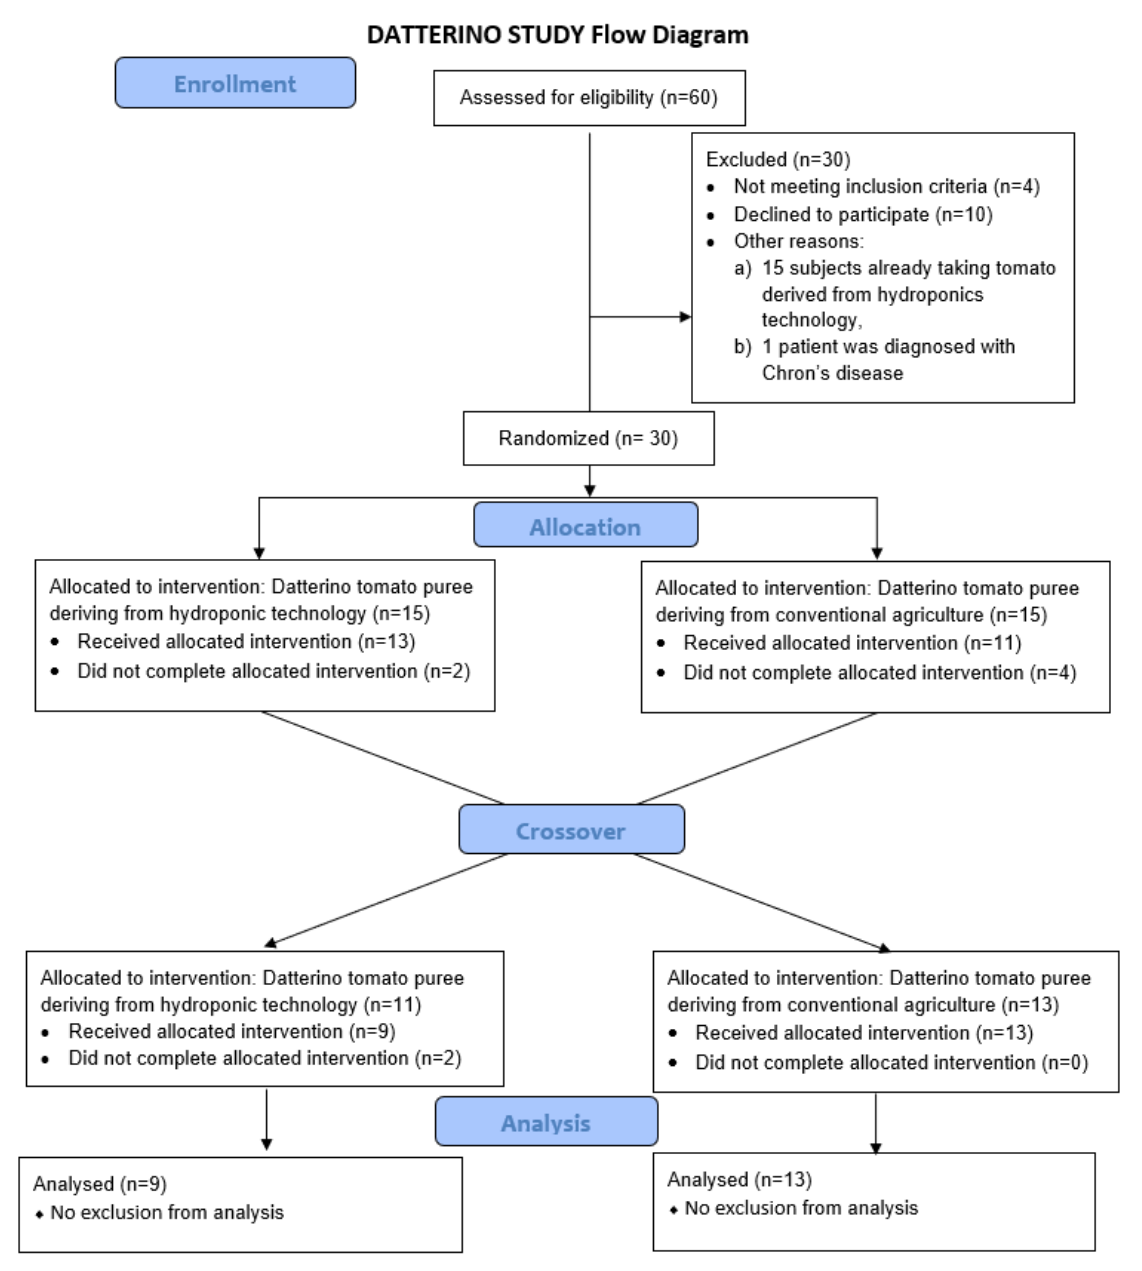
Figure 3. CONSORT diagram flow of